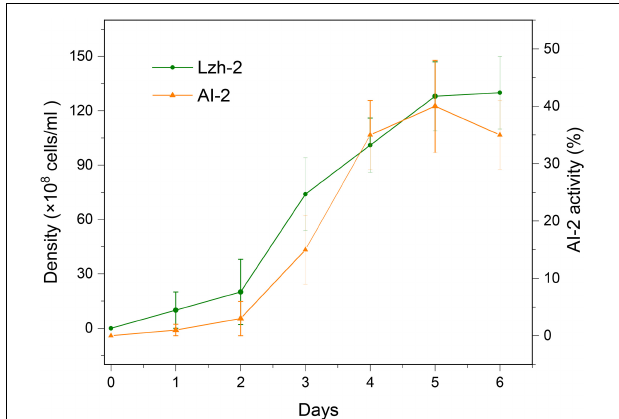
FIGURE 2 | The density of the Lzh-2 strain (green) and the activity of AI-2 produced (orange).